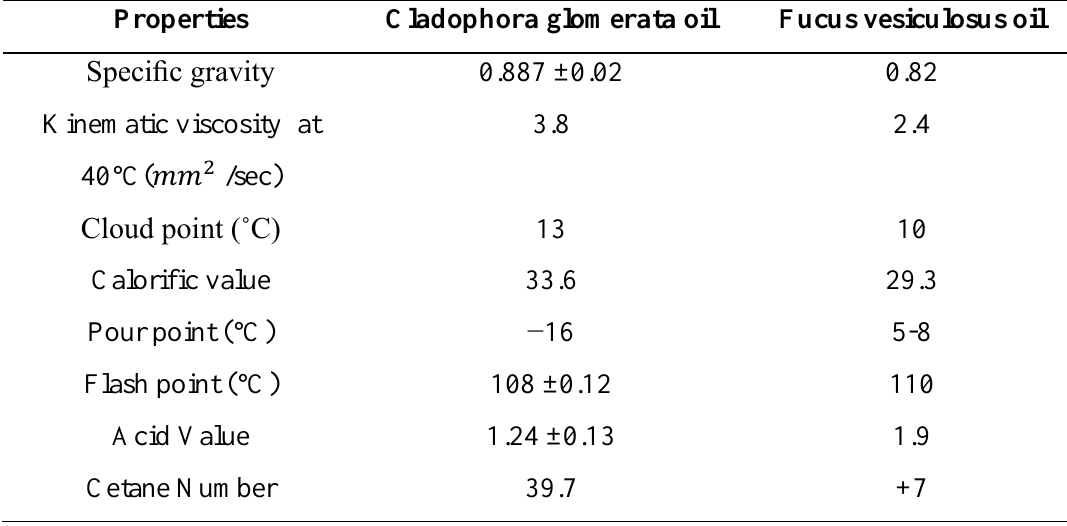
Table 4. Properties of the oils of algae produced in the present